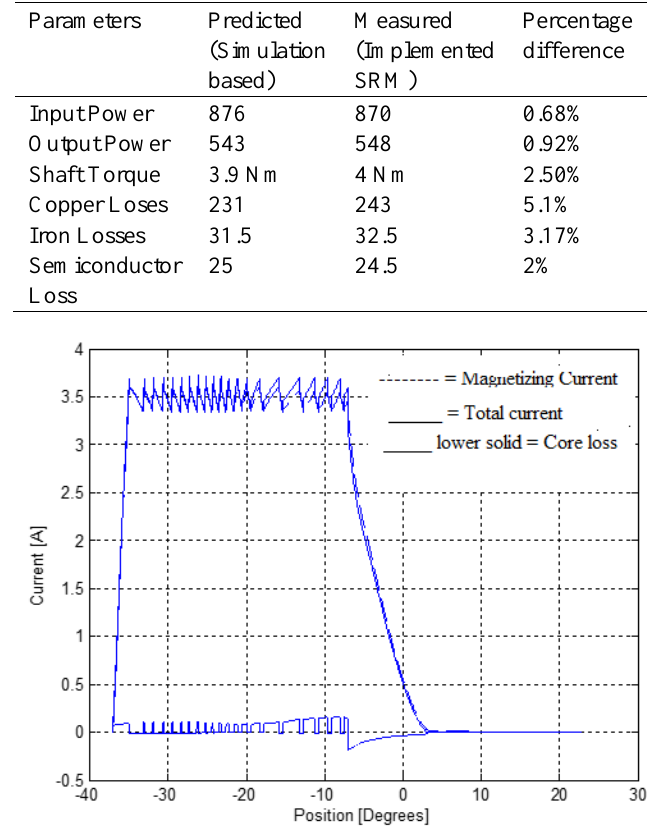
Estimated Loss Parameters at 30 Conduction Angle in Single